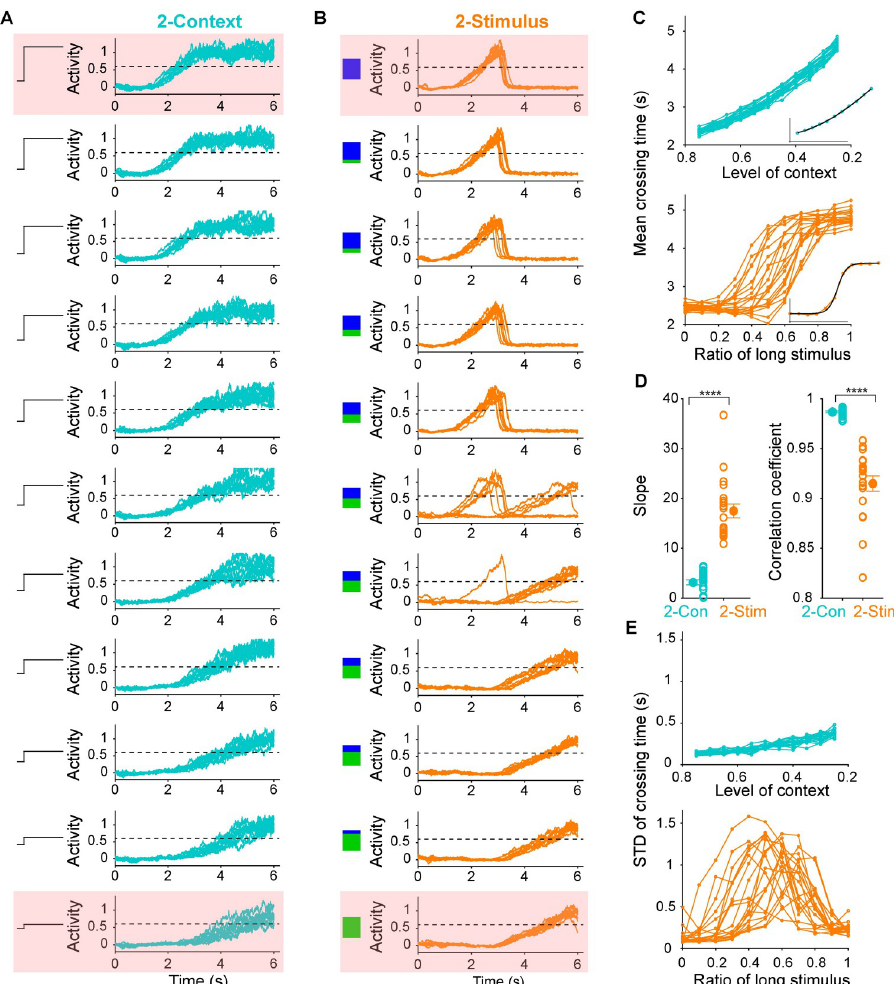
Fig 2. RNNs trained on the 2-Context task exhibited smooth generalization to novel intervals, while RNNs trained on the 2-Stimulus task exhibited categorical timing. ( A ) Output traces of an RNN trained on the 2-Context task across different context input levels. Dashed-black lines denote the output threshold used to quantify timing. Pink squares denote the trained conditions. ( B ) Similar to ( A ) but for the 2-Stimuls task. The blue and green squares represent the ratio of activation of the two input units. ( C ) Plots of the mean crossing time for each RNN across input conditions for the 2-Context (top) and 2-Stimulus (bottom) tasks. Insets, examples of the sigmoid-function fits for a single RNN (black). ( D ) Left, mean slope of the sigmoid fits for 2-Stimulus task is significantly higher than that for the 2-Context task ( n = 20 simulations for each, two-sided t test, t = 9.69, P < 0.0001). Right, correlation coefficient 38 between mean crossing times and input conditions for 2-Context task is significantly higher than that for the 2-Stimulus task ( n = 20 simulations for each, two-sided t test on Fisher-transformed values, t 38 = 17.39, P < 0.0001). The absolute correlation coefficient values are shown because in the 2-Context task the correlations are negative. ( E ) Standard deviations of the crossing times for each RNN in the 2-Context (top) and 2-Stimulus (bottom) tasks, as a function of input